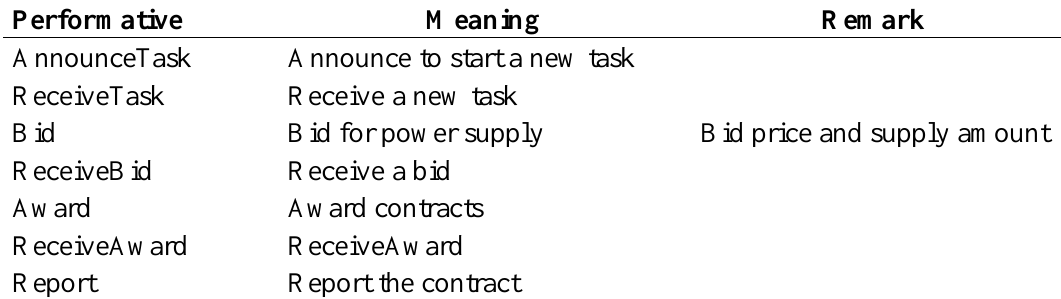
Table 3. Performatives for P2.